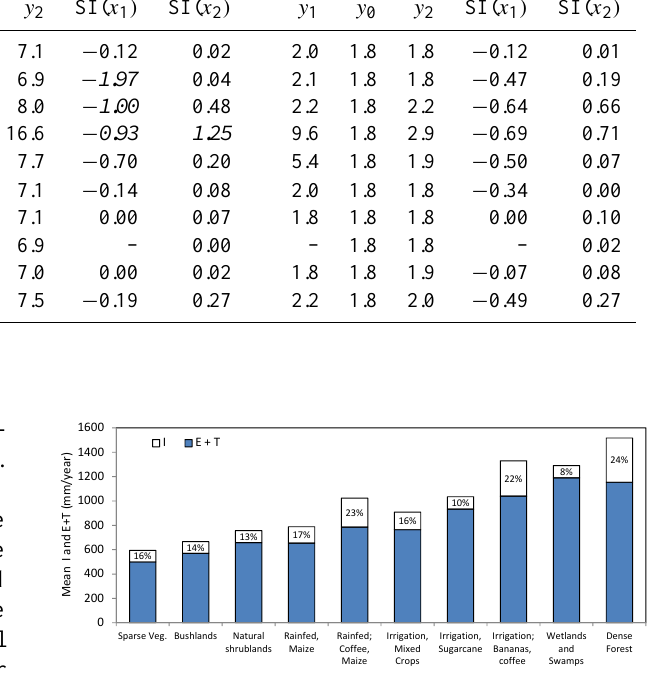
Table 2. Sensitivity of model performance due to change in model input parameters. Input values Parameter